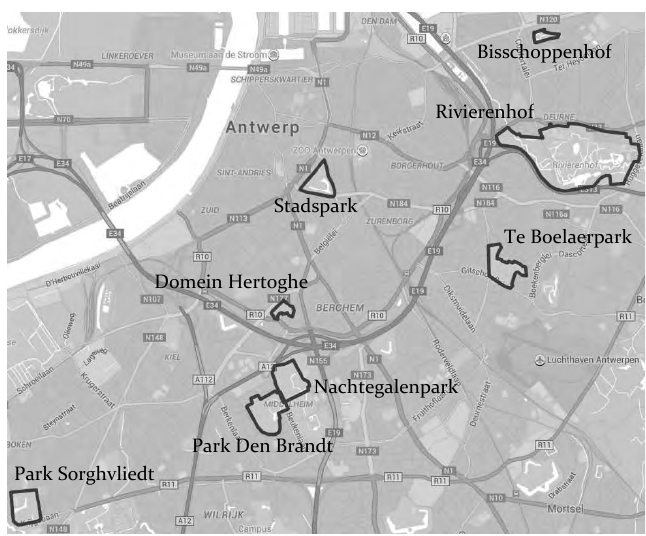
Figure 1. Locations of the eight parks in the city of Antwerp studied in the survey